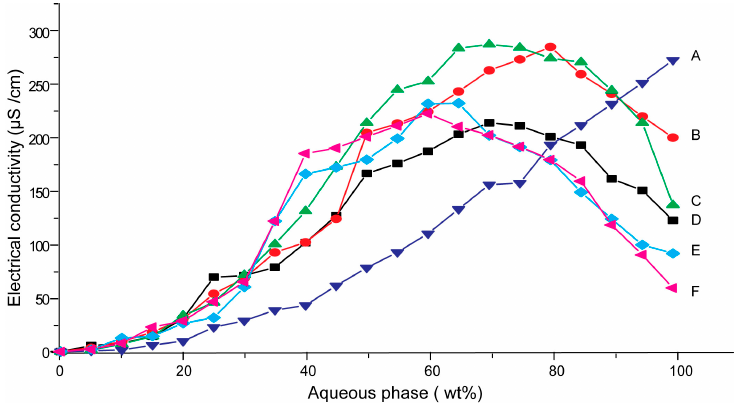
Figure 1. Electrical conductivity as a function of the water content (wt. %) for self-microemulsifying drug delivery systems (SMEDDS) containing ( A ) acacia, ( B ) dextran 40, ( C ) maltodetrin, ( D ) PVP K30, or ( E ) blank microemulsion and ( F ) drug loaded microemulsion.